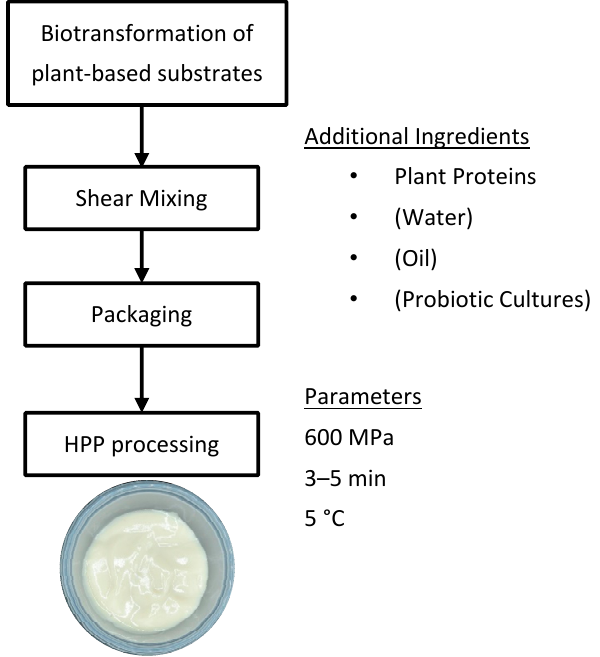
Figure 4. A proposed plant-based yogurt-making process using biotransformation for optimized flavor production and high pressure processing (HPP) for consistent texture generation. The bracketed ingredients are optional depending on formulation. The image shows HPP-structured mung bean yogurt (MBSO) in a cup.